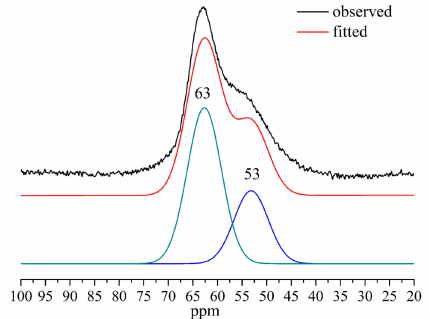
Figure 7. 27 Al MAS–NMR spectra of Al-tobermorite of Al / (Al + Si) = 0.1.